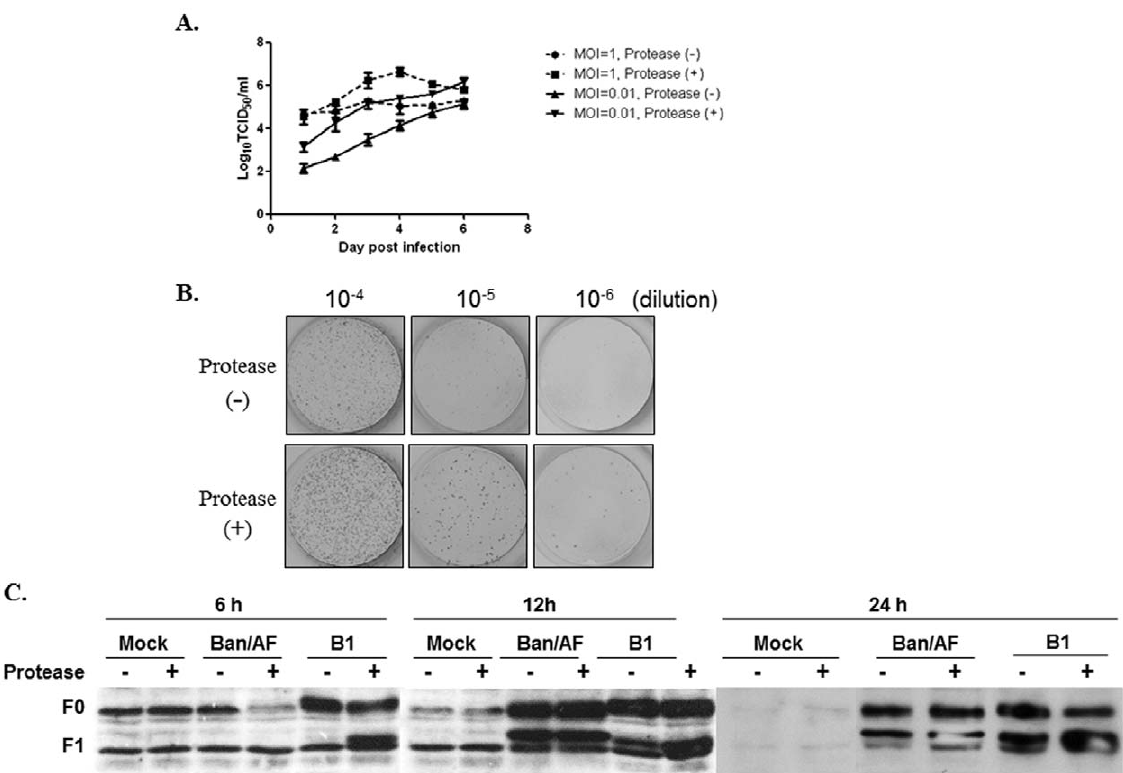
Figure 4. Effect of exogenous protease on the growth and F protein cleavage of the Ban/AF virus in DF1 cells. (A) Cells were infected with the mutant Ban/AF at an MOI of 1 and 0.01, and cultured in the presence or absence of 10% normal allantoic fluid. 100-ul aliquots of culture supernatants were collected daily for titration of viruses by the TCID50 assay. (B) Cells were infected with a 10-fold dilution series of allantoic fluid from Ban/010-infected eggs, and cultured in the presence or absence of 10% normal allantoic fluids. The cells were fixed and immunostained using anti-NDV N protein antiserum (20), followed by incubation with secondary antibody and detection by substrate AEC plus chromogen (Dako, USA). (C) Cleavage of the Ban/AF and B1 F proteins in infected DF1 cells. The cells were infected with viruses at an MOI of 1. The cell lysates were collected at 6, 12 and 24 h post infection. Western-blot was performed with an anti-NDV F cytoplasmic tail peptide rabbit serum.